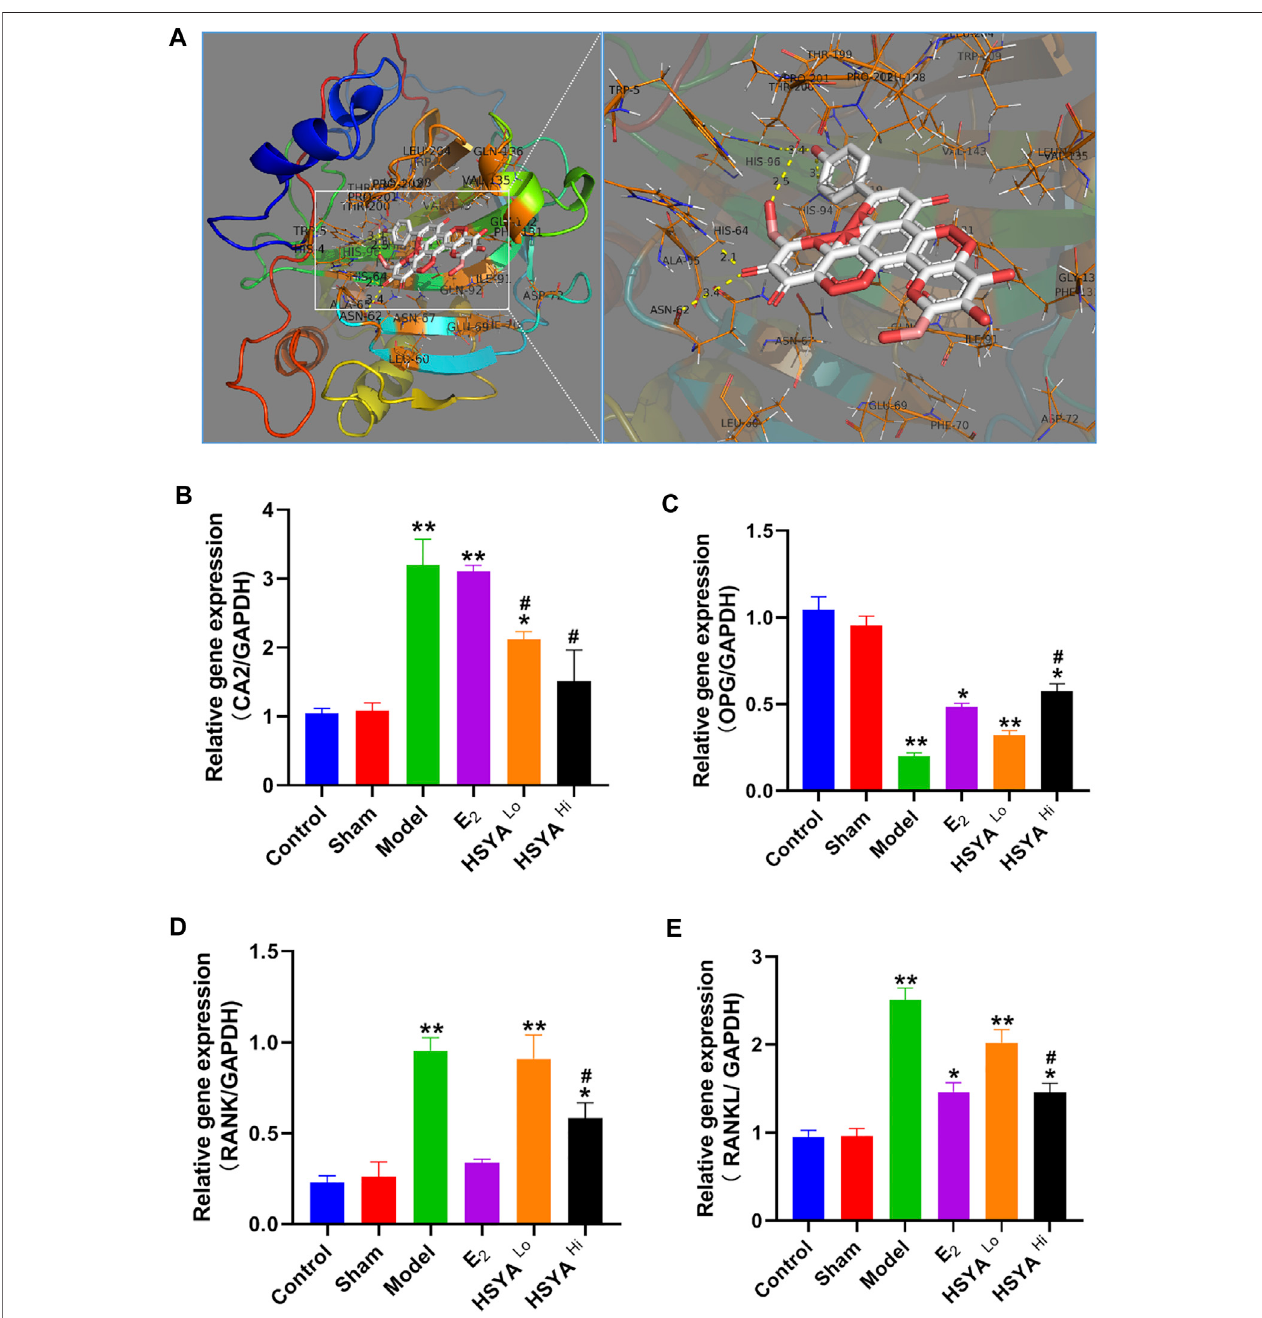
FIGURE6| regulationofCA2andosteoclastdifferentiation-relatedgenesbyHSYA. (A) PymolmolecularsimulationofHSYAandCA2dockingresults. (B) qPCRto detect the relative expression level of CA2 gene in rat femur. (C) qPCR to detect the relative expression level of OPG gene in rat femur. (D) qPCR to detect the relative expression level of RANK gene in rat femur (E) qPCR detected the relative expression level of RANKL gene in rat femur. “ ** ” means p < 0.01, “ * ” means p < 0.05, compared with the control group, the difference is statistically signi fi cant. “ # ” indicates p < 0.05, the difference was statistically signi fi cant in the HSYA treatment group compared with the model